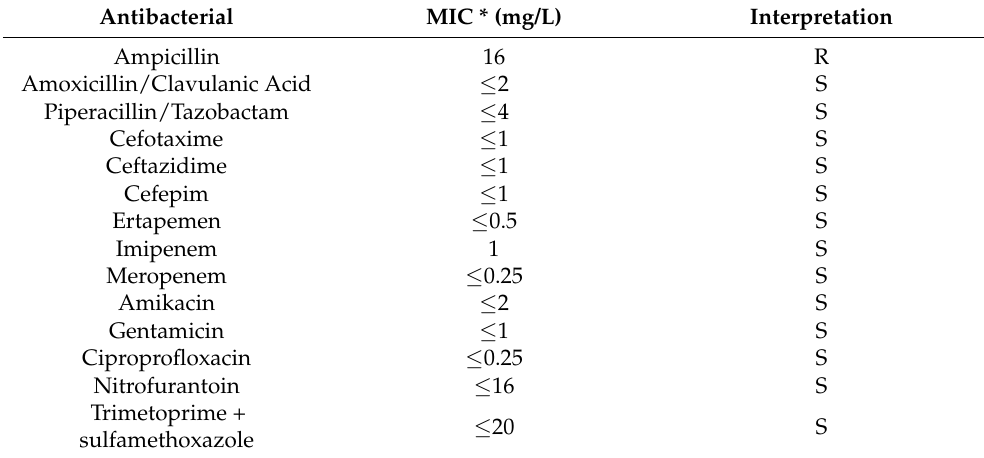
Table 1. Susceptibility results obtained in vitro on VITEK ® 2 system for Raoultella planticola (isolated pure culture obtained from urine, US pump and isotonic solution).